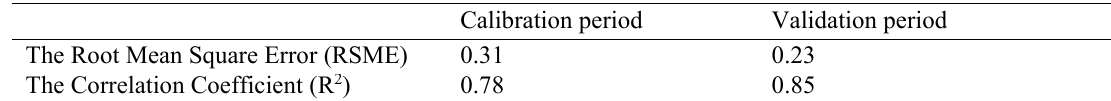
Table 2 The results of statistical